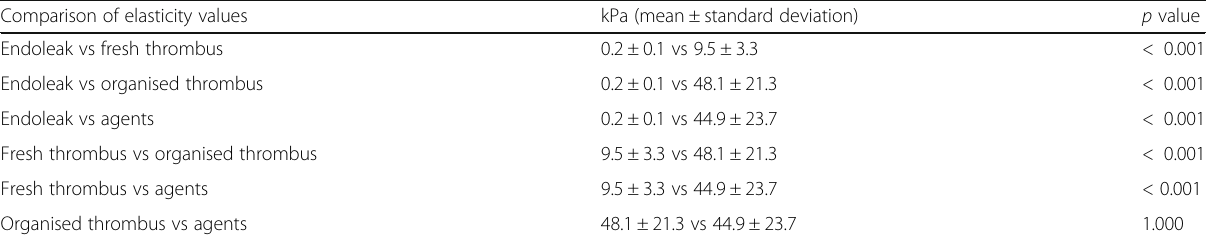
Table 2 Tukey comparisons of the mechanical properties of the regions of interest at sacrifice at three or six months Comparison of elasticity values